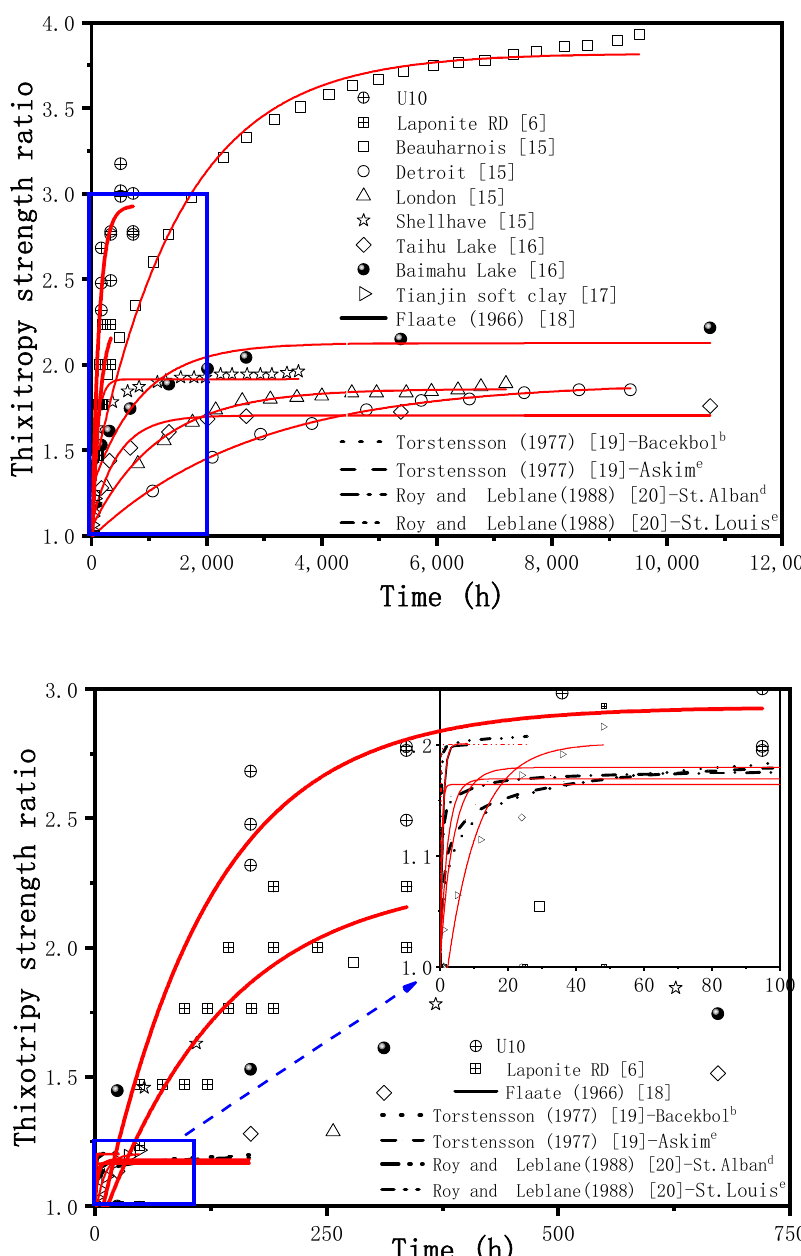
Figure 9. Thixotropy strength ratio for the synthetic transparent clay compared with natural clays. The sensitivity of soil is an indication of the reduction in shear strength of the soil when disturbed, e.g., when it is remolded or when it is subjected to monotonic or cyclic Table 1. Summary of relationships between thixotropic ratio and time. loading. Soil sensitivity is defined as the ratio of the undrained shear strength of undis- turbed soil to the undrained shear strength of the remolded soil at the same water content, i.e., S t = S u /S ur (where S u and S ur are the undisturbed and remolded undrained shear strengths, respectively). The ratio of the peak undisturbed strength to the remolded strength, as determined by the unconfined compression test, was used initially by Terzaghi as a quantitative assessment of sensitivity. However, the strength of some clays is so low that unconfined compression test specimens cannot be used. Therefore, the laboratory vane shear test was used in this work. The remolded shear strength was measured by manual rotation after obtaining the peak shear strength and performing an additional laboratory test. Figure 10 shows the peak strength and residual strength change versus time, while